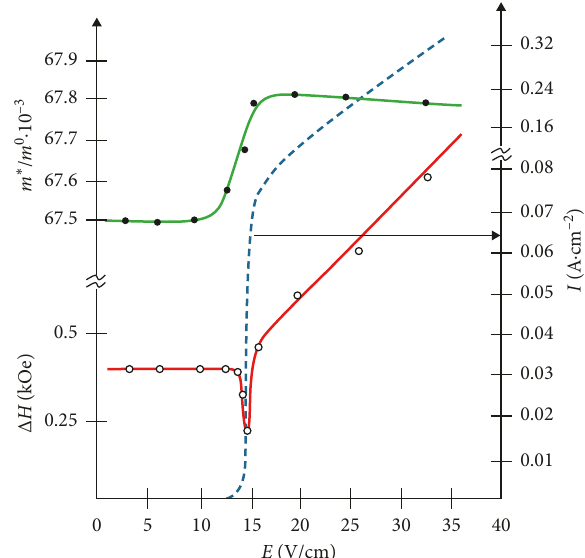
Figure 12: Dependence of the cyclotron mass and the CR line width of the sample I on the electric field at T � 4 . 2K and λ ≈ 119 μ m. The solid dots and the open dots indicate the cyclotron mass and the line width, correspondingly. The dashed curve sig- nifies the CVC of the sample I which is measured in the constant current regime.